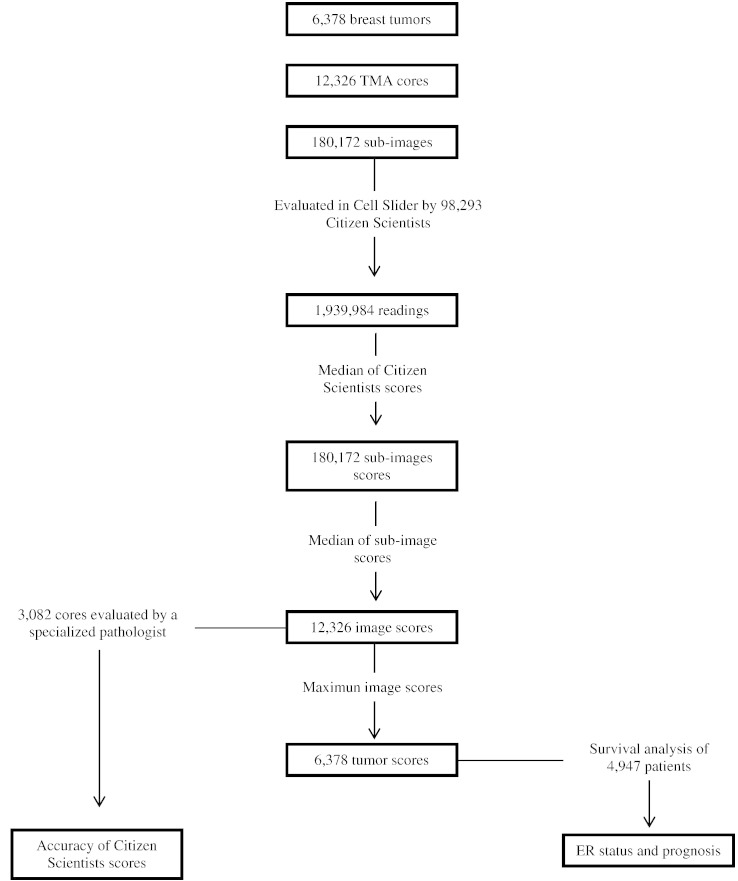
Flowchart of study design showing details of score calculation (sub-image, image and tumor), comparison with pathologist evaluation and survival analysis.